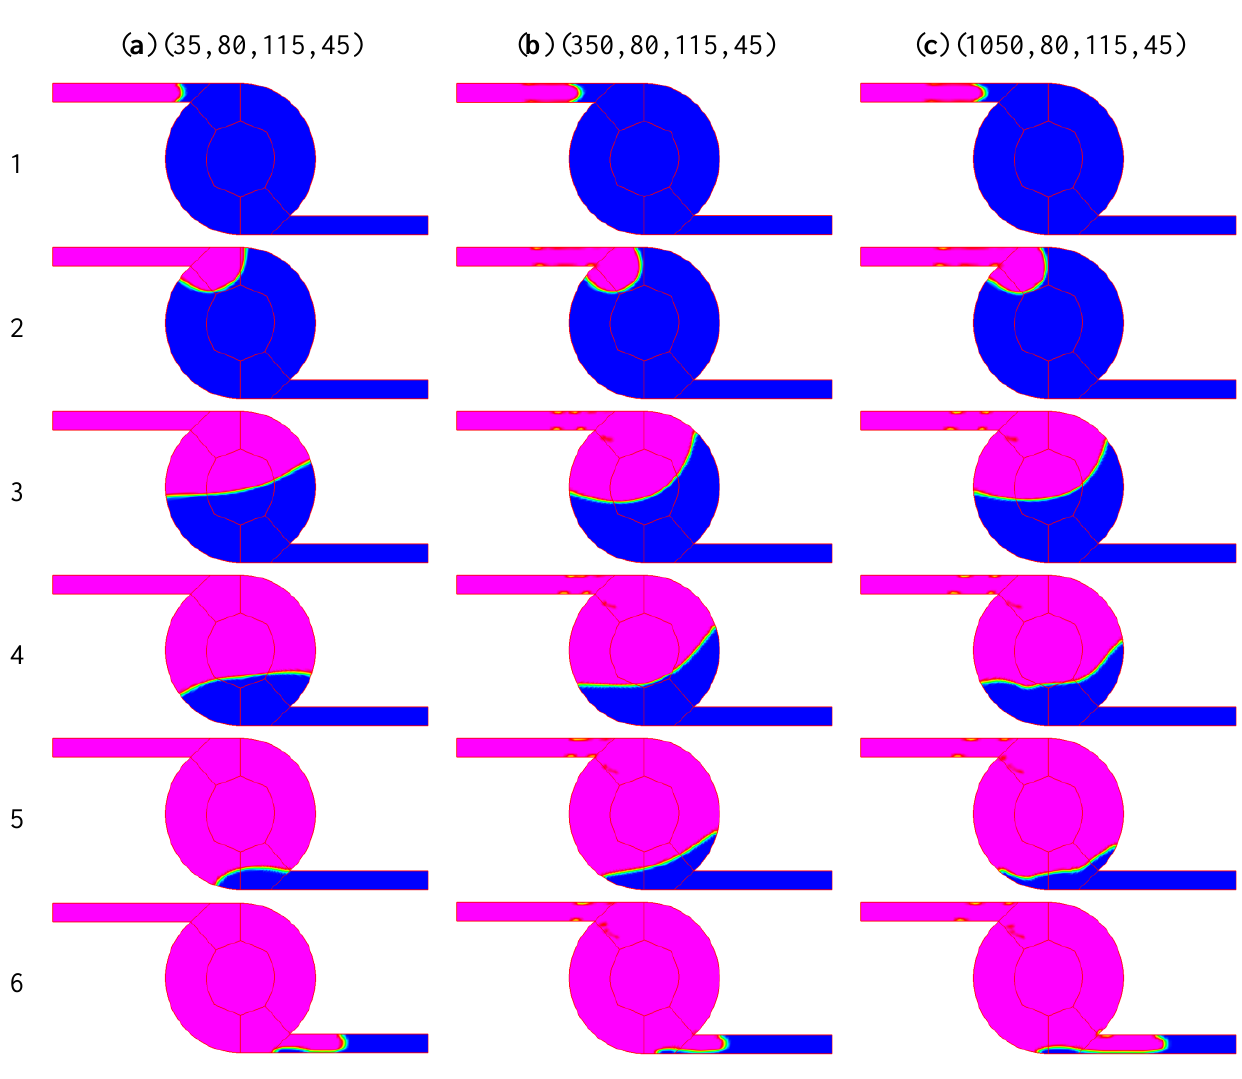
is 80°, θ is 45° and θ s lc is uc